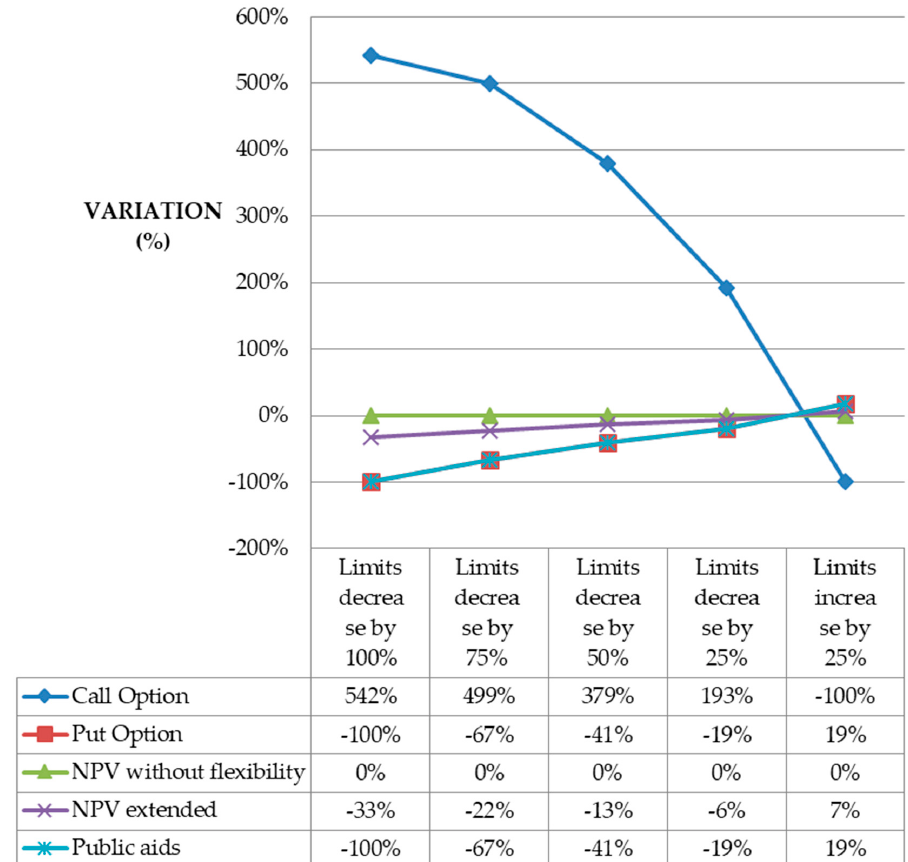
Figure 6. Percentage variation in base scenario (source: own elaboration).